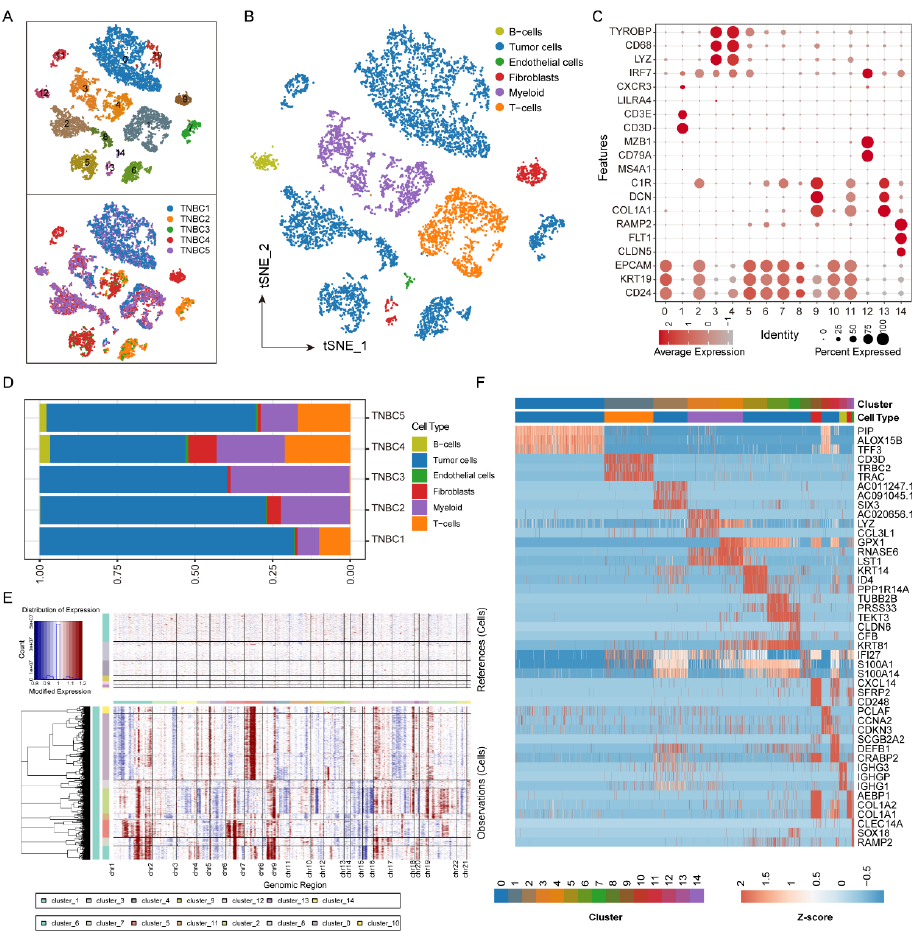
Figure 1. Cellular composition of TNBC and identification of malignant cells. ( A , B ) The t-SNE visualization of 8938 cells identified by scRNA-seq across five TNBC tumors. Clusters were marked for the top of ( A ) and patients’ information were marked for the bottom of ( A ). The cell types were annotated for ( B ). ( C ) Average expression of gene markers of each cell type. ( D ) Relative proportions of cell types for each TNBC patient. ( E ) Heatmap showing the inferred CNA profiles for reference and malignant cells. Chromosomal amplification and deletion were colored by red and blue, respectively. Each row represents a single cell, and each column denotes a chromosomal position. ( F ) Heatmap showing the expression levels of top three gene markers for each cell clusters.